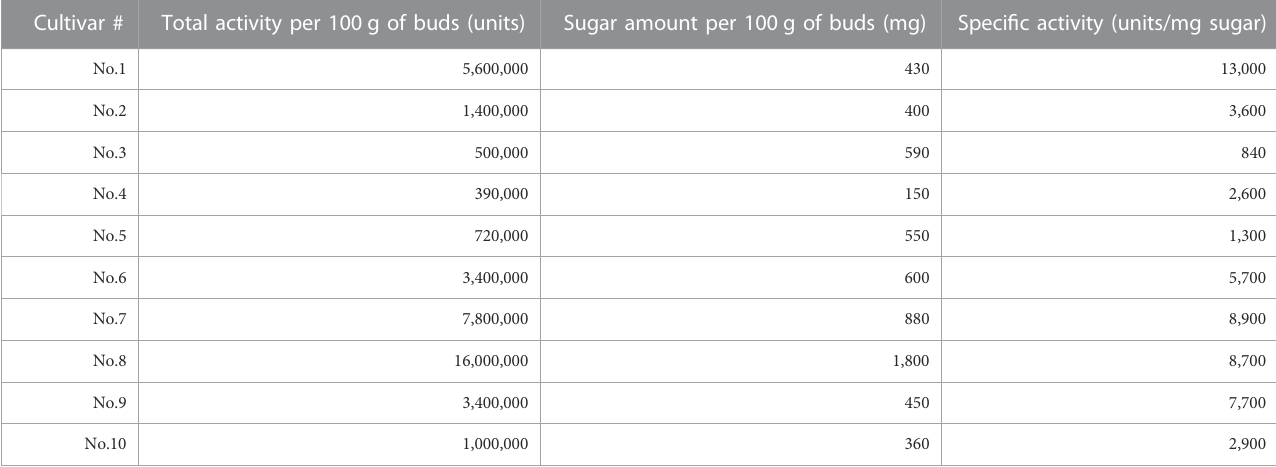
TABLE 2 List of broccoli cultivars and their immunostimulatory activities used for cultivar set #1 (ten commercial cultivars). There was a signi fi cant difference across cultivars; Akaike ’ s Information Criterion (AIC) for full model (AIC full = − 272.8) was lower than that for the null model (AIC null = − 256.8). Cultivar